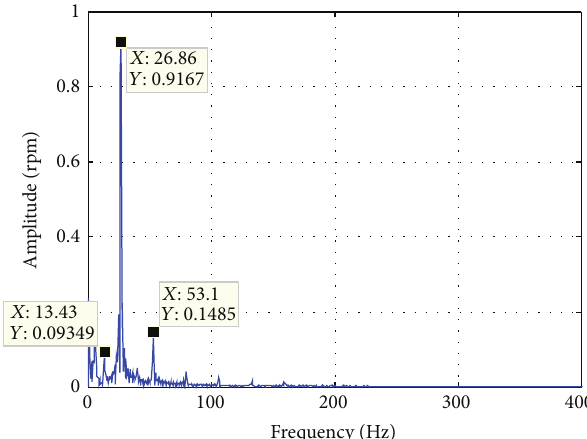
Figure 38: Frequency spectrum of clutch hub speed.